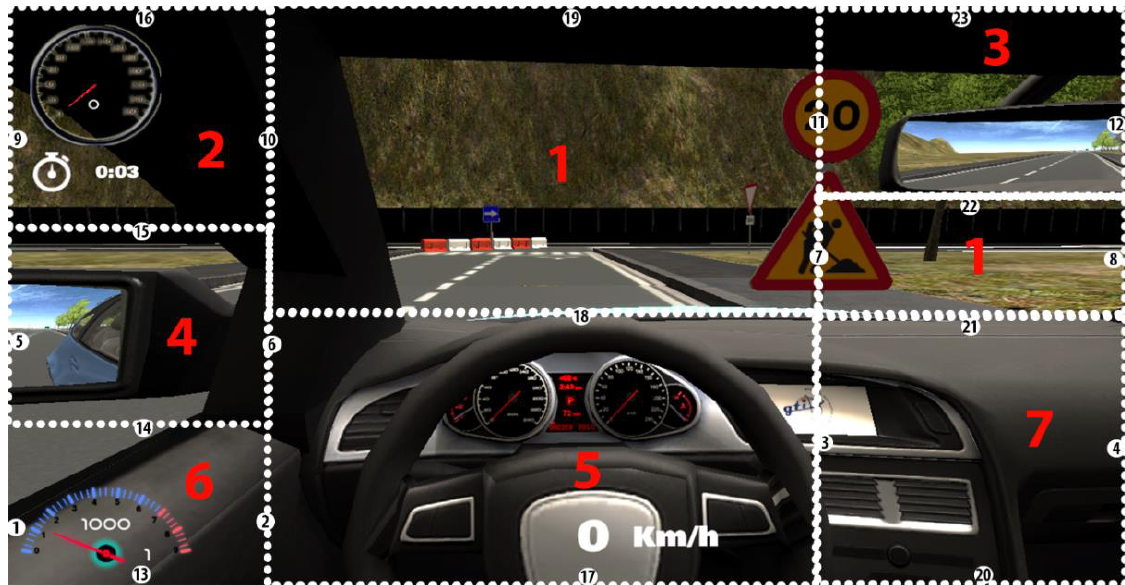
Figure 7. Calibration points along the border of the seven regions (numbered 1 to 7) used in method 2.